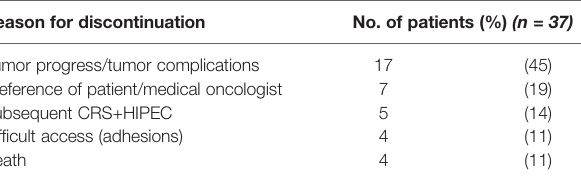
TABLE 1 | Reasons for completing less than three cycles of PIPAC